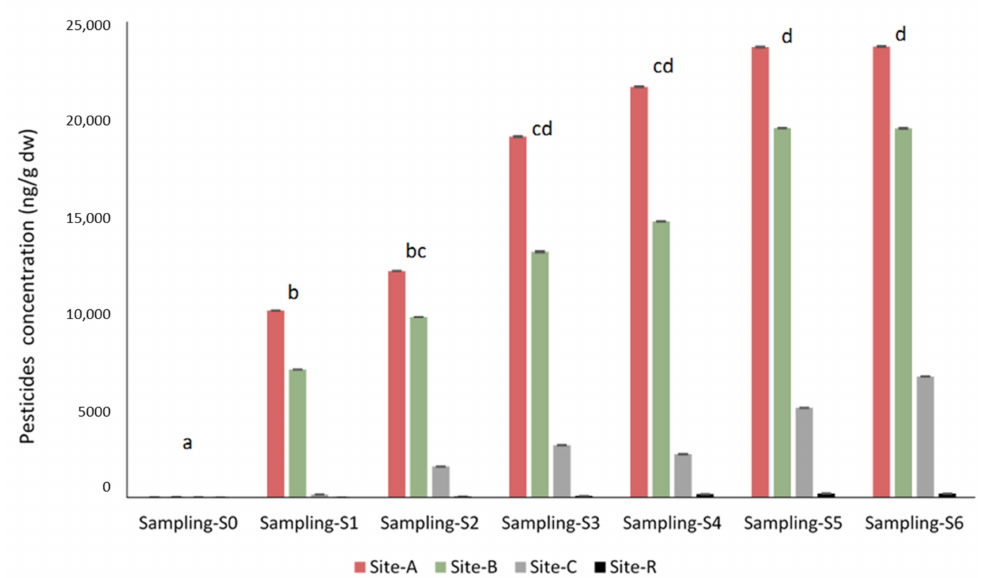
Figure 5. Concentration of total pesticides (ng/g dw) in the snails sampled from the four sampling sites, Site-A: middle of apple orchard, Site-B: border of apple orchard, Site C: control spot of apple orchard, Site-R: reference site (Aamiq). The data are presented as mean ± RSD (n = 3 for each site). Differing lowercase letters shown represent significant difference between the total concentration of pesticides (semi-volatile and non-volatile) accumulated by the snails and quantified on each sampling date based on Fisher pairwise comparisons (95% confidence